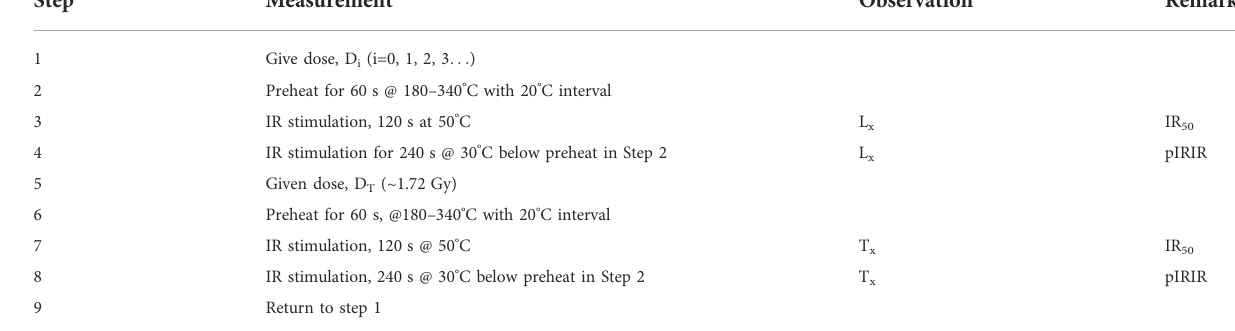
TABLE 1 Modi fi ed SAR protocol for pIRIR